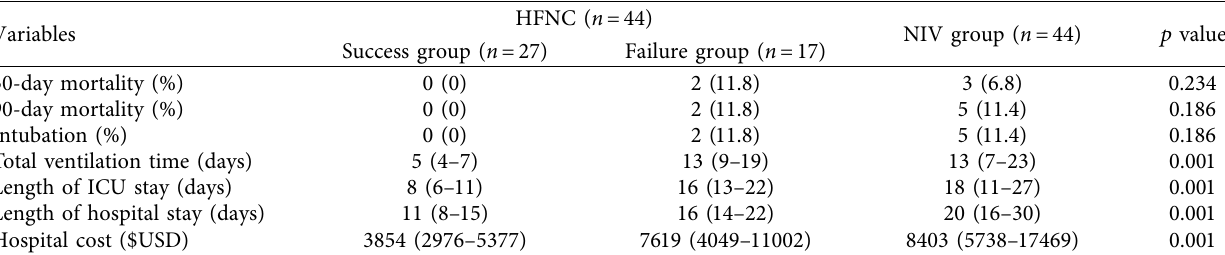
Figure 2: Kaplan–Meier curves for length of ICU stay (a), length of hospital stay (b), and total ventilation time (c) in HFNC success (red), HFNC failure (blue), and NIV (green) groups (log-rank test, p � 0 . 001 for all). Table 5: Clinical outcomes of HFNC success, HFNC failure, and NIV